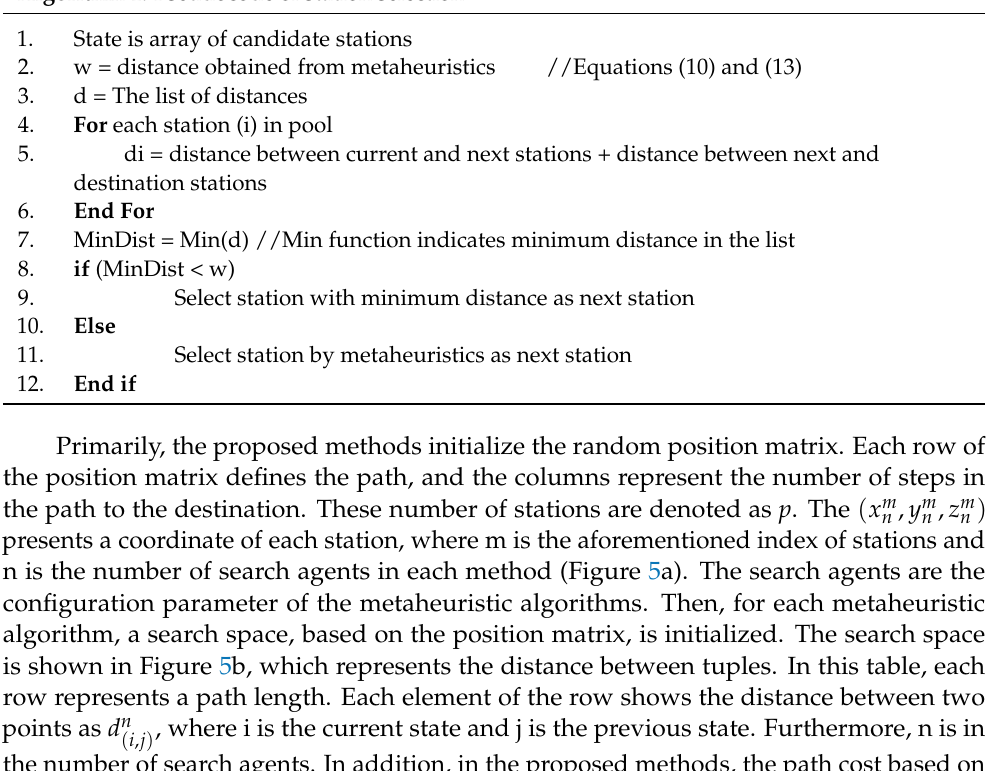
Algorithm 1. Pseudocode of station